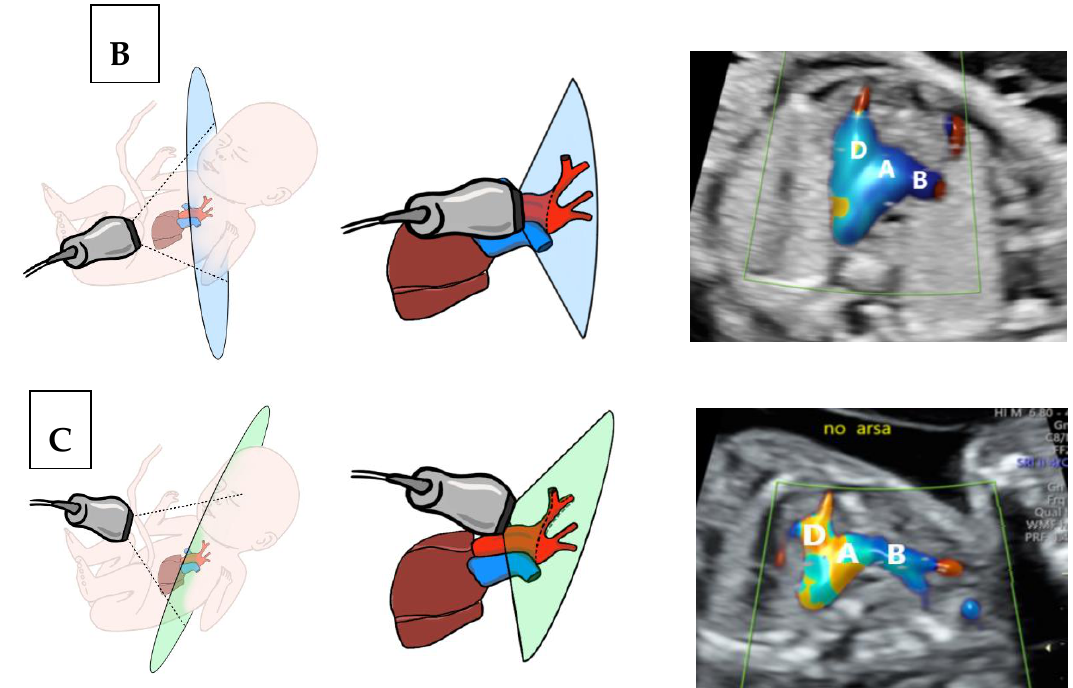
Figure 1. “No ARSA” plane acquisition: The brachiocephalic artery arises from the aortic arch and crosses anterior to the trachea and towards the right side of the fetus. The angle of insonation to acquire the corresponding plane to demonstrate ( A ) three-vessel trachea (3VT) view ( B ) brachiocephalic artery origin ( C ) brachiocephalic artery bifurcation, the “No ARSA” sign. ARSA, aberrant right subclavian artery; D, Ductus arteriosus; A, Aortic arch; B, Brachiocephalic artery.